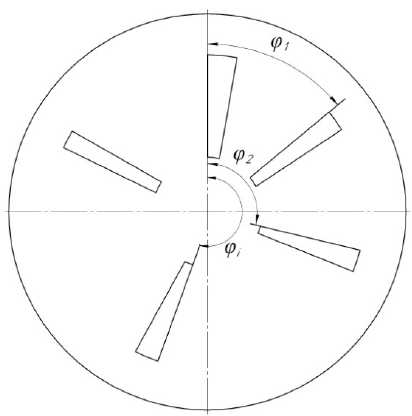
Figure 3. Location of the windows on the stator disk.